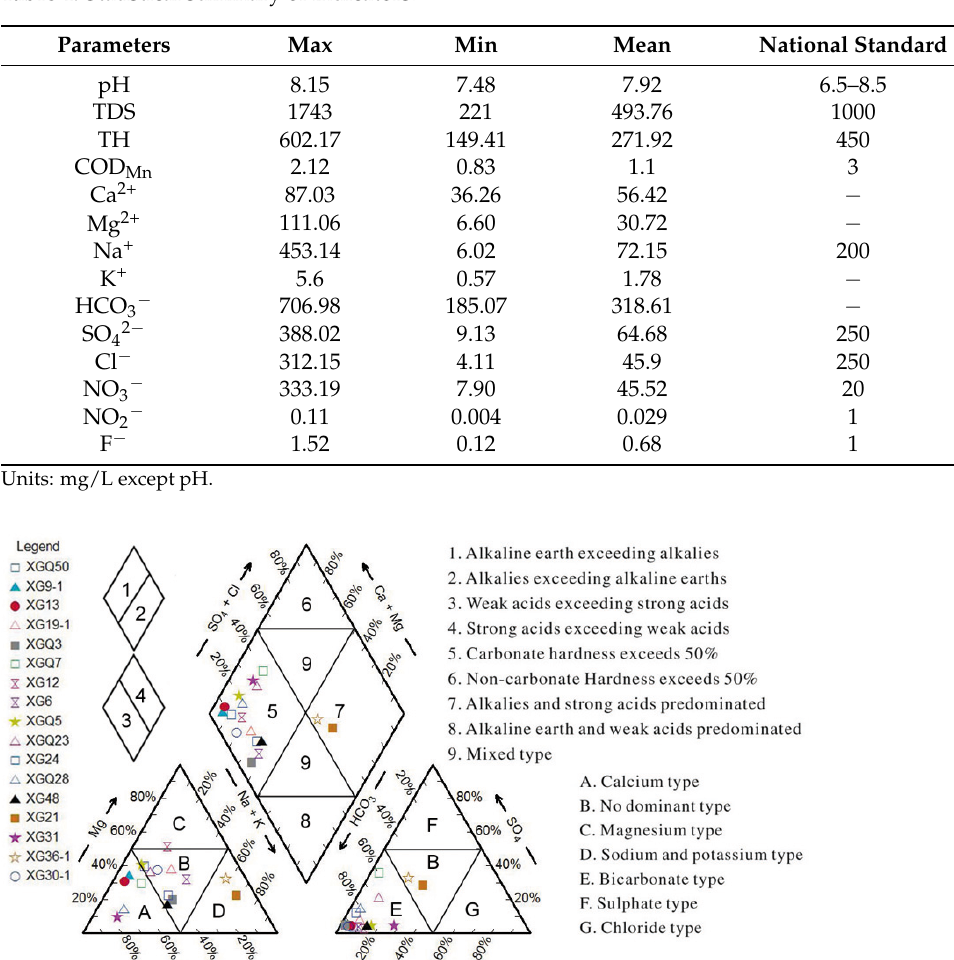
Table 4. Statistical summary of indicators.